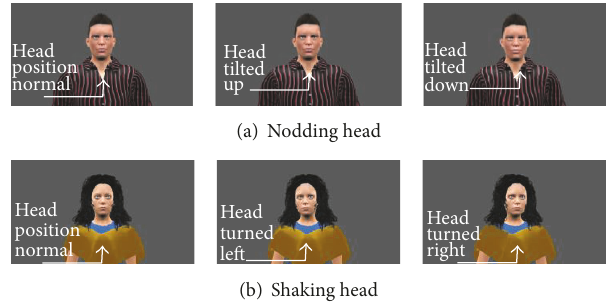
Figure 4: Frames used to generate head